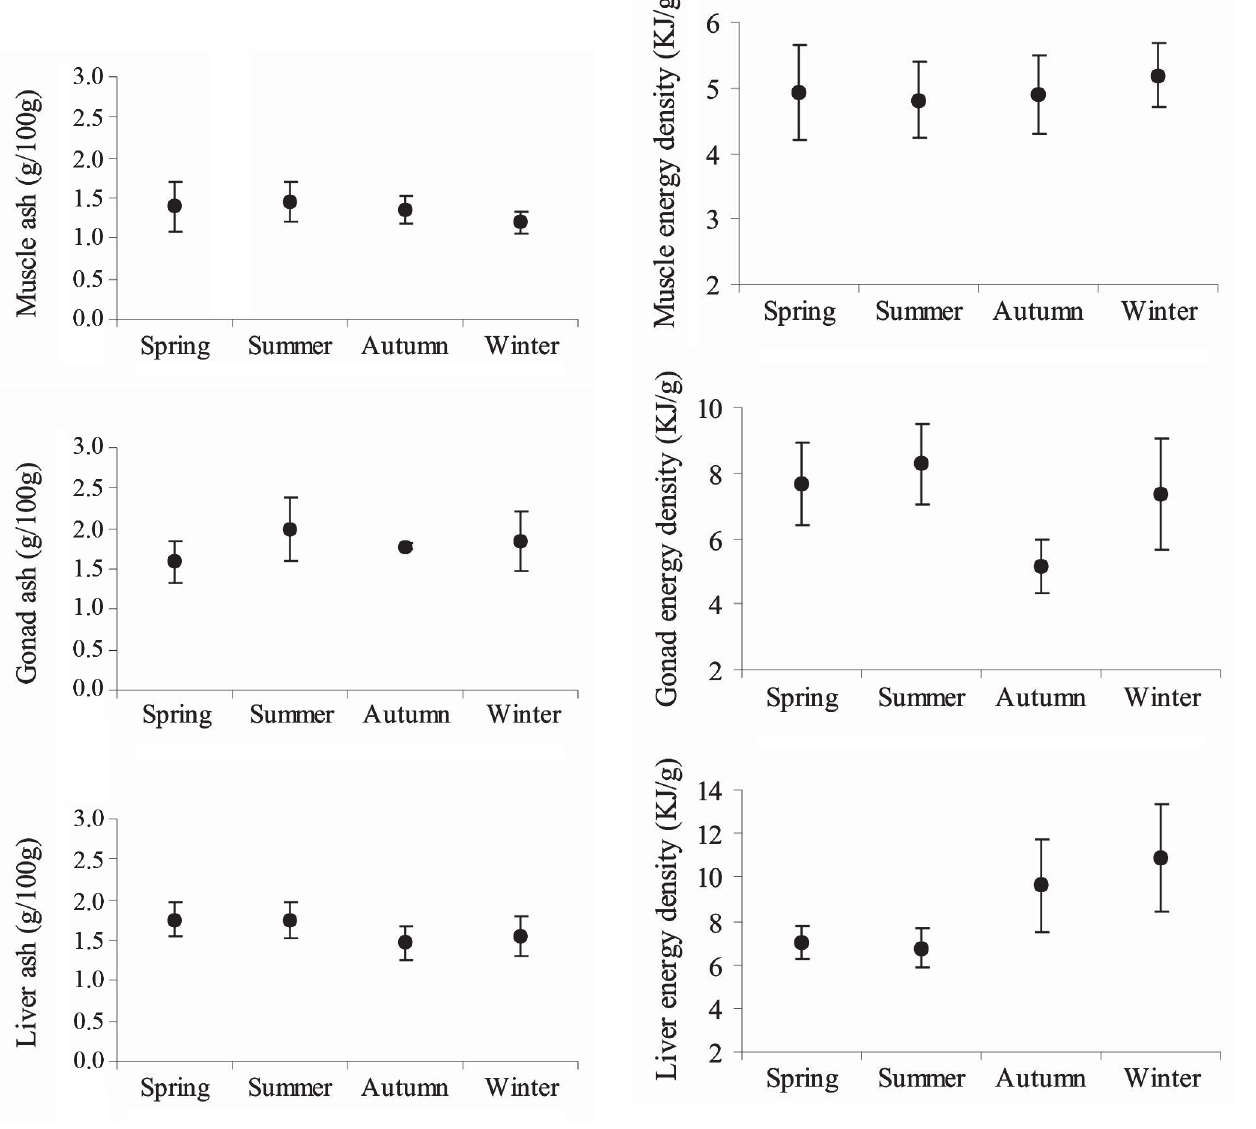
Fig. 5. Seasonal variation of inorganic matter content (ash) in muscle, gonad and liver of Percophis brasiliensis .